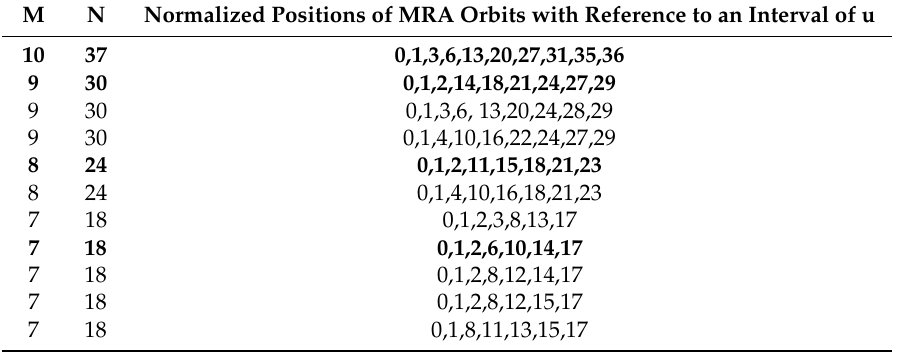
Table 1. Normalized distributions of minimum redundancy array (MRA) orbits. M N Normalized Positions of MRA Orbits with Reference to an Interval of u